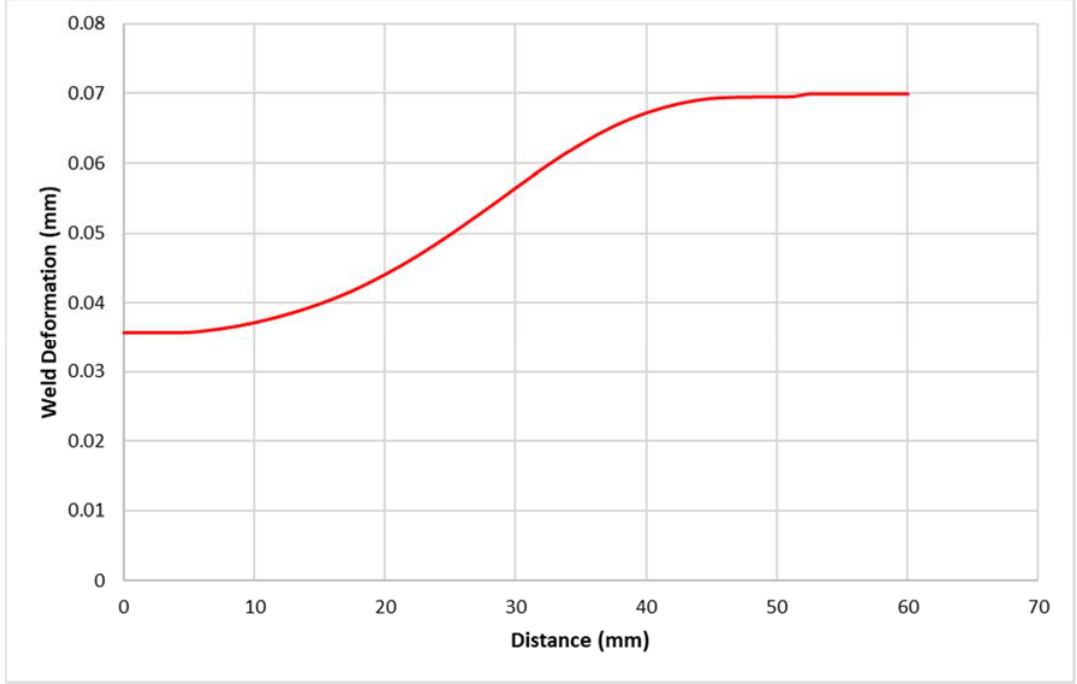
Figure 13. Weld deformation profile along the Y ‐ axis.